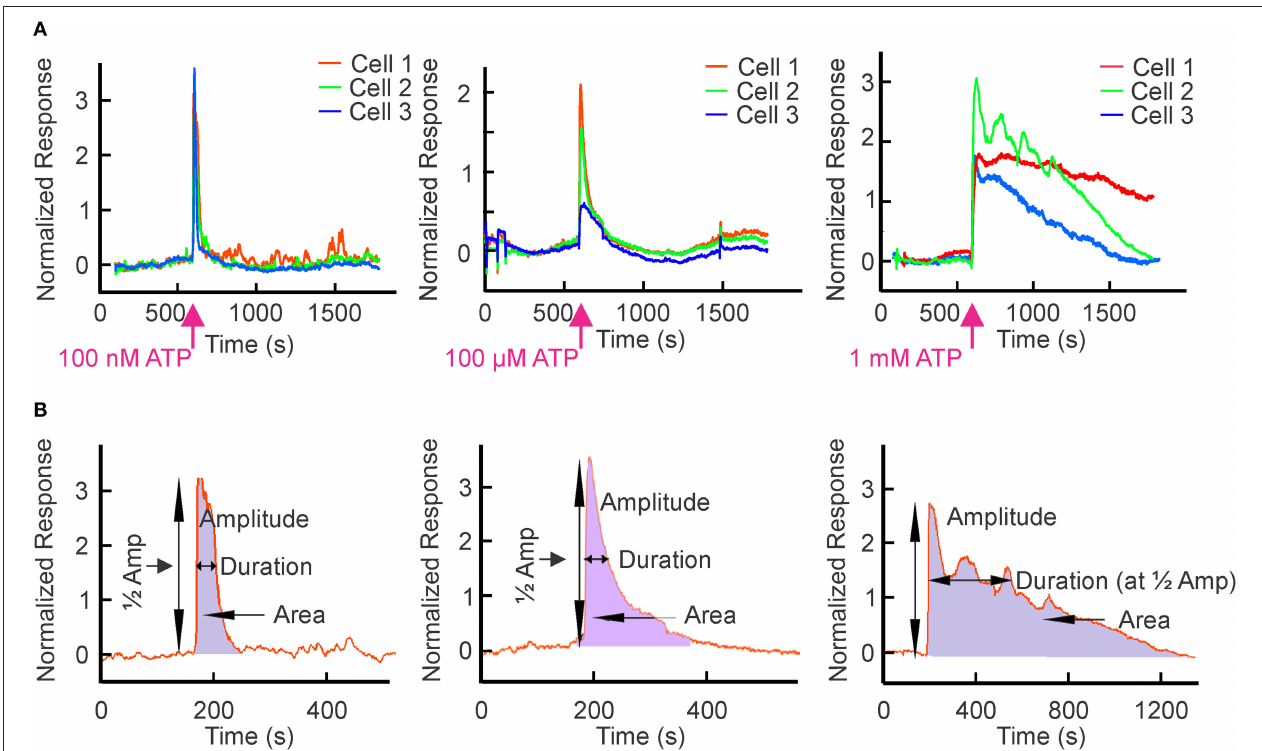
FIGURE 3 | ATP-induced Ca 2 + responses in osteoblastic cells. MC3T3-E1 cells were loaded with the Ca 2 + sensitive dye fluo-4 and changes in [Ca 2 + ] i in response to bath application of ATP were monitored by confocal microscopy. [Ca 2 + ] i in individual cells was normalized as (F/F 0 ) − 1, where F was fluorescence intensity and F 0 was the baseline fluorescence observed prior to addition of ATP. (A) Representative calcium responses from osteoblasts exposed to 100nM, 100 µ M or 1mM ATP at the time indicated by the arrow. (B) The schematics illustrate parameters used to analyse the calcium response curves. Peak amplitude was quantified as the maximal rise in [Ca 2 + ] i . Duration of the response was quantified as the width at the half maximum. The amount of calcium released was calculated as the area under the curve by taking the integral of the